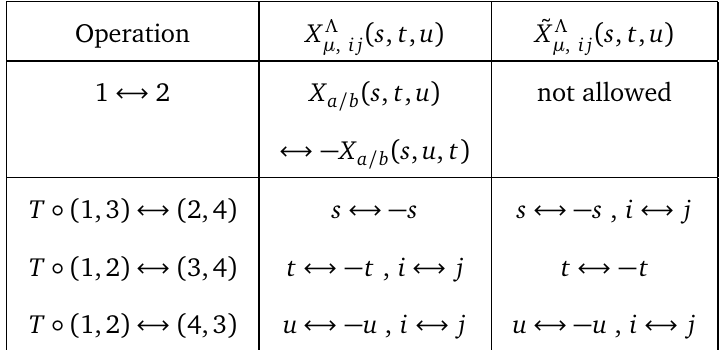
Table 1: Transformations of the frequency arguments under time reversal T and Λ ij Λ ij specific permutations of indices in X and ˜ X . The exchange 1 ↔ 2 would 1,2 | 3,4 1,2 | 3,4 change X to the form X and ˜ X to X . Hence, the resulting symmetries take c x y yx ji | ij the slightly different form in Eq. (23). Equivalent relations hold for X Λ → Y Λ and ˜ X Λ → ˜ Y Λ